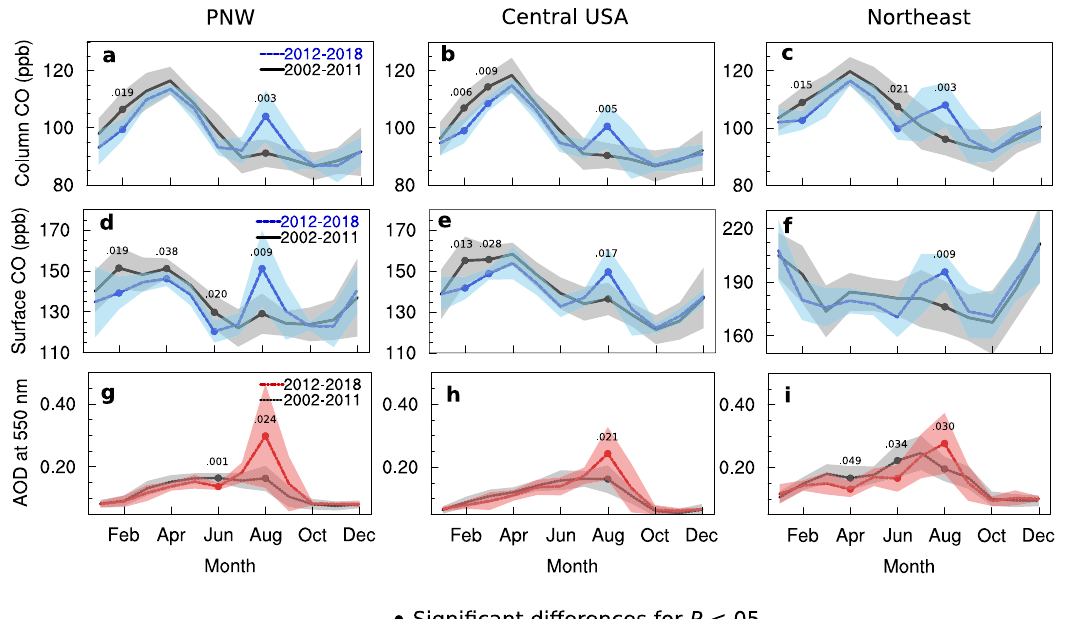
Fig. 3 Seasonal patterns of atmospheric composition. Regional seasonal patterns of atmospheric composition are shown for two different time periods: 2002 – 2011 (black line with gray shading) and 2012 – 2018 (blue or red). a – c Measurements of Pollution in the Troposphere (MOPITT) carbon monoxide (CO) as column average volume mixing ratio (VMR) in parts per billion (ppb). d – f MOPITT surface CO VMR. g – i Moderate Resolution Imaging Spectroradiometer (MODIS) aerosol optical depth (AOD). Regions are the Paci fi c Northwest (PNW), Central USA, and the Northeast. The shaded area shows the standard deviation and fi lled circles represent data means that are signi fi cantly different between the two time periods with P values noted for a two-tailed t -test. More complete statistics relevant for the August differences can be found in Table 1. The Northern Hemisphere background CO trend 2002 – 2018 of − 0.50 ppb per year was removed prior to seasonal cycle calculation for ( a ) – ( f